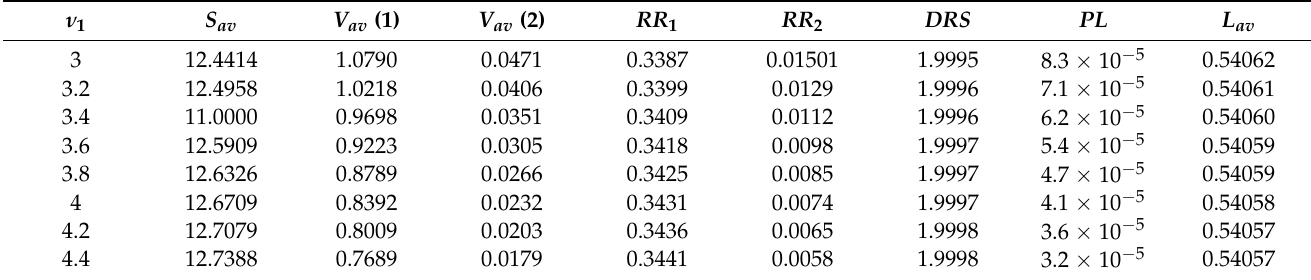
Table 6. Dependence of the performance measures on parameter ν 1 ; λ = 2, µ 1 = 5, µ 2 = 6, κ = 2, ν 2 = 5, τ = 2, r = 3, s = 8, S =